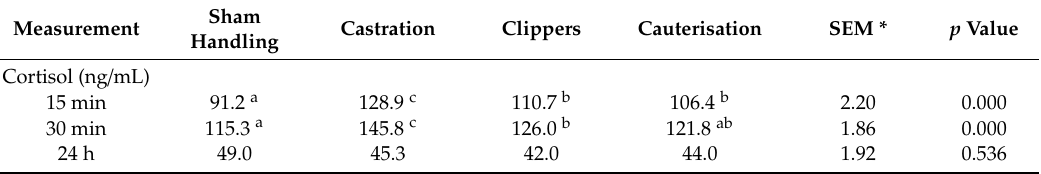
Table 2. E ff ect of treatment on cortisol concentrations at 15 and 30 min and 24 h post-treatment.